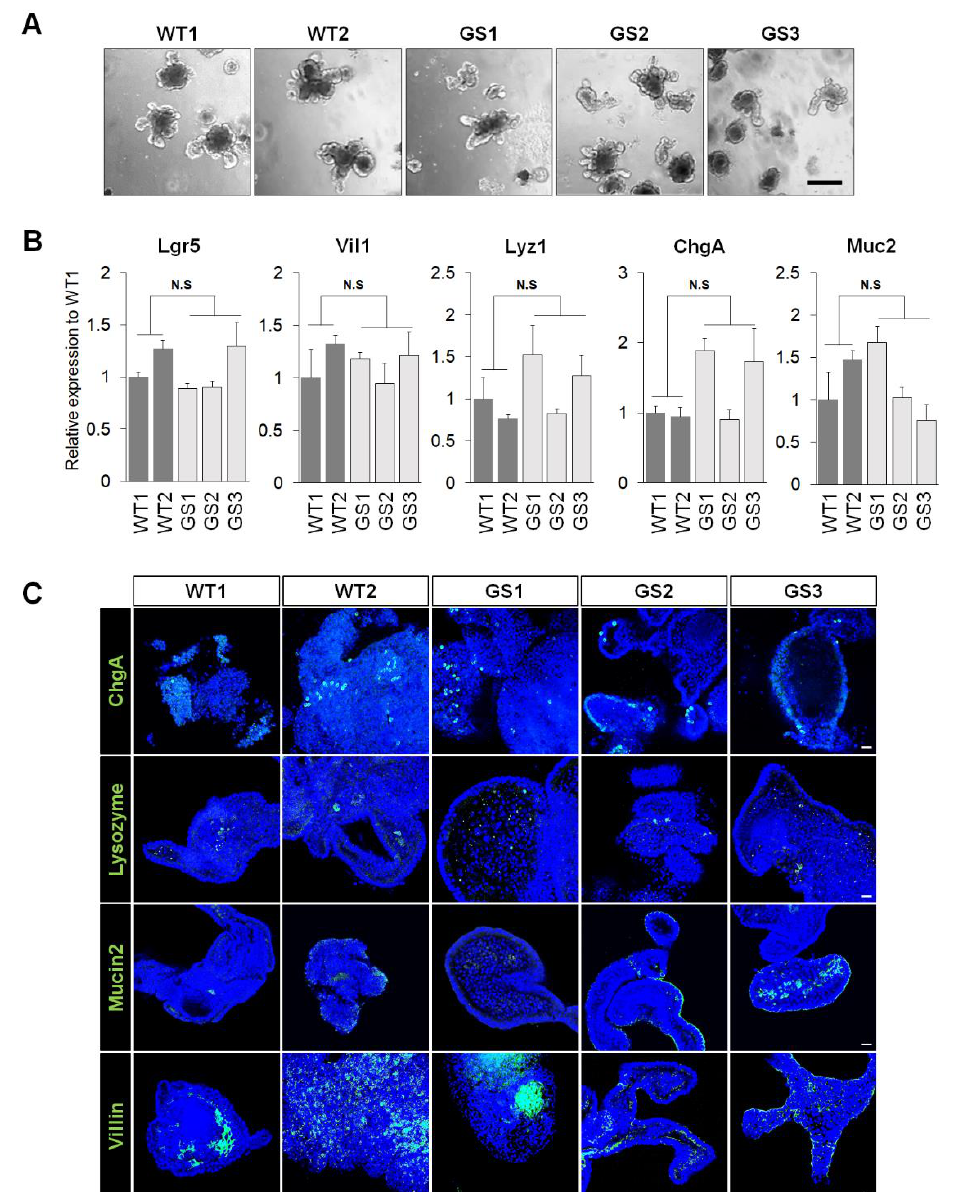
Figure 1. Establishment of intestinal organoids as an ex vivo model. ( A ) Isolated mouse intestinal crypts efficiently formed small intestinal organoids. (scale bar 200 μm) Wild-type (WT), Non-transgenic littermate mouse small intestinal organoids; Leucine-rich repeat kinase 2 ( LRRK2 ) Gly2019Ser substitution (G2019S) (GS), The human LRRK2 G2019S mutant mouse small intestinal